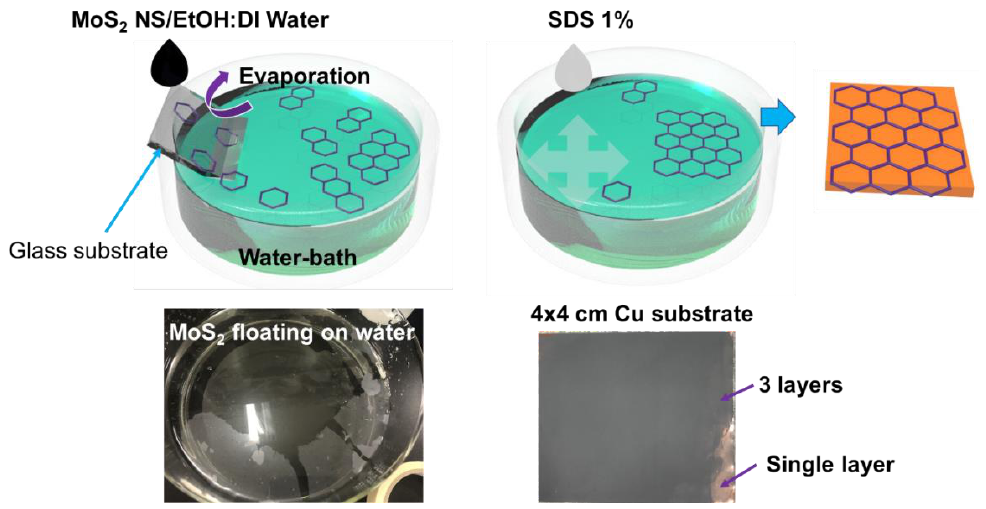
Figure 1. Illustration and photographs of self-assembled MoS 2 nanosheet (NS) on Cu substrate.